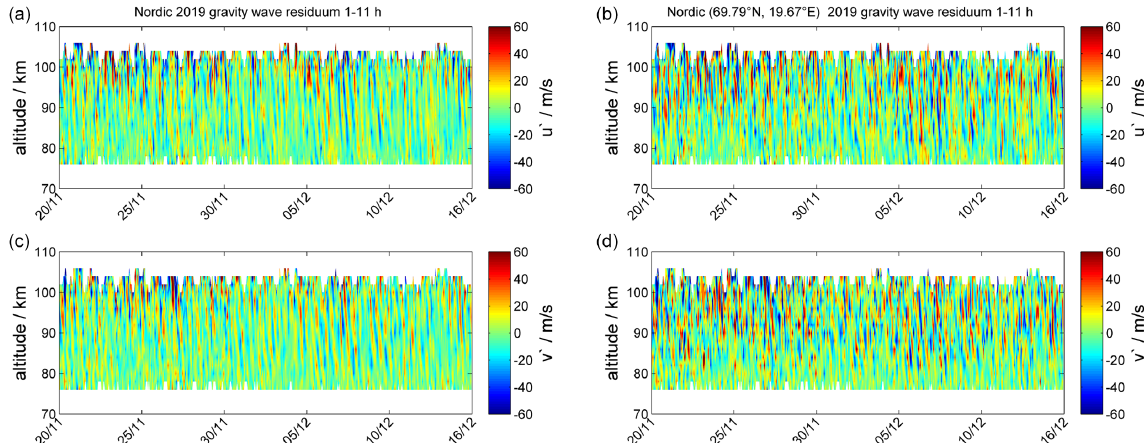
Figure 11. Panels (a) and (c) show the zonal and meridional gravity wave residuum for all waves in the period range between 1 and 11h with color-coded amplitude integrated over the Nordic domain from 20 November to 15 December 2019. Panels (b) and (d) highlight the same but for the grid cell located around geographic latitude (69.79 ◦ N, 19.67 ◦ E) down to horizontal scales of